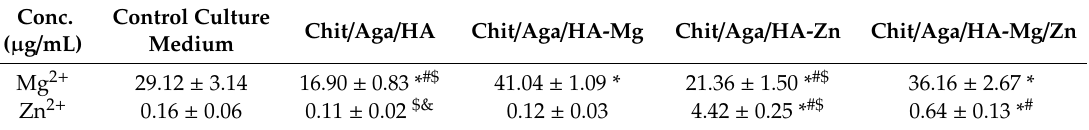
Table 2. Mg 2 + and Zn 2 + ion concentrations [ µ g / mL] in sca ff old extracts prepared by 24 h incubation of Table 2. Mg 2+ and Zn 2+ ion concentrations [µg/mL] in scaffold extracts prepared by 24 h incubation of the materials in culture the materials in culture medium.